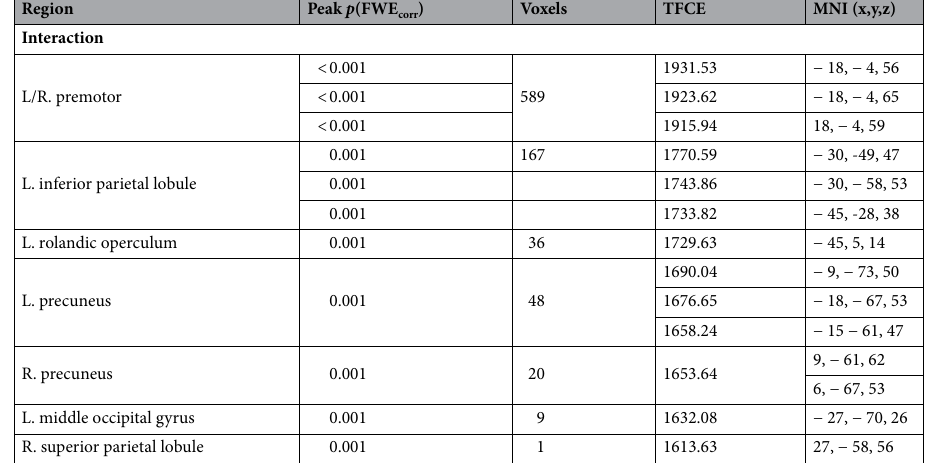
Table 3. Non-parametric TFCE results from significant 2 × 2 group by time interaction estimated with 5000 permutations for the thalamus seed region. Results show a significant decrease in the PPI Learning contrast from the thalamus to the bilateral premotor, parietal, and occipital regions. Results shown at a p < 0.0012 family-wise error corrected